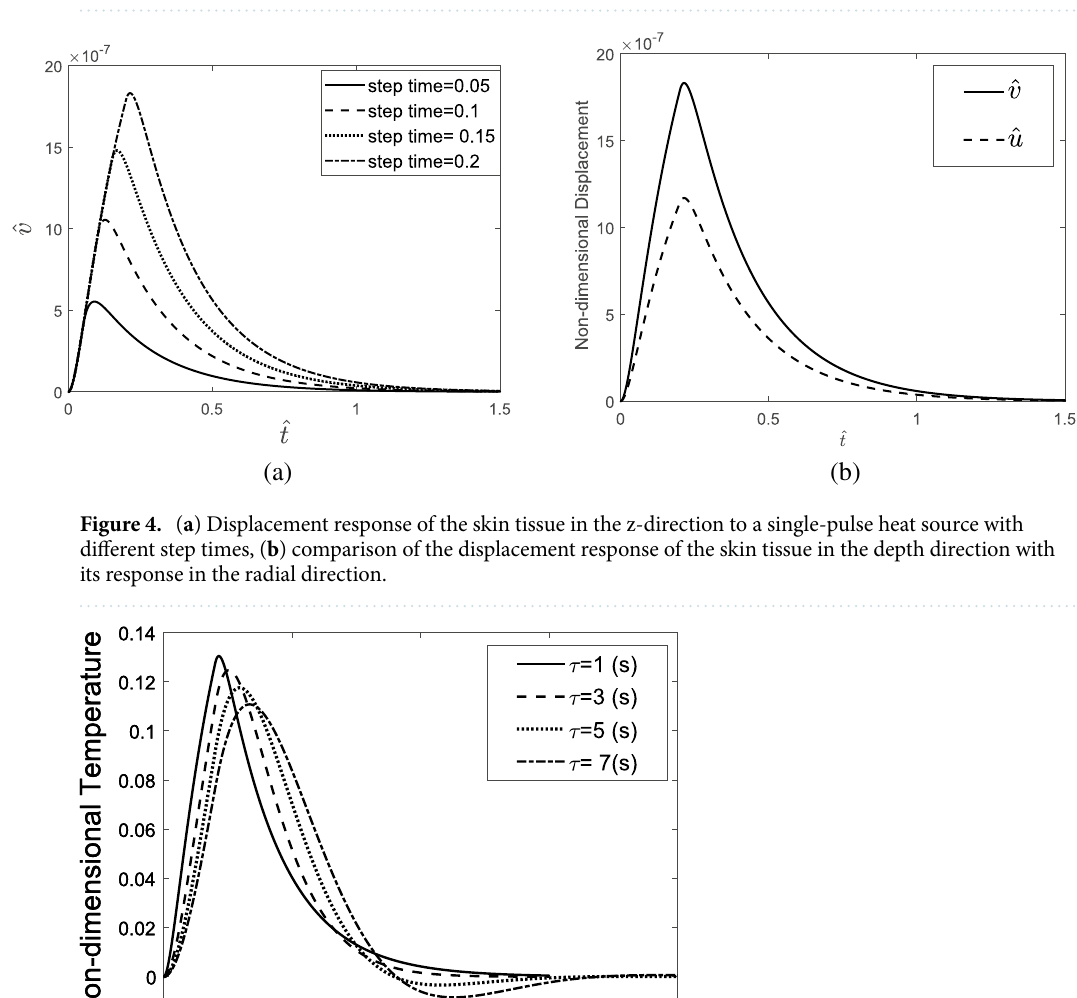
Figure 3. ( a ) Single-pulse heating source, ( b ) temperature response of the skin tissue to a single-pulse heat source with different step times.